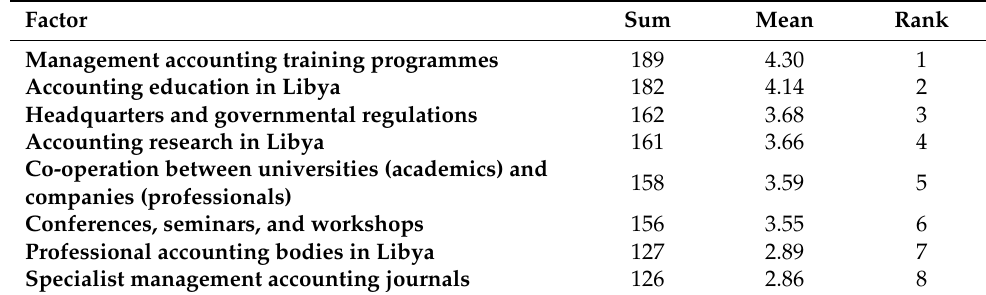
Table 9. Institutional factors facilitating the adoption of MAIs in the manufacturing sector. Factor